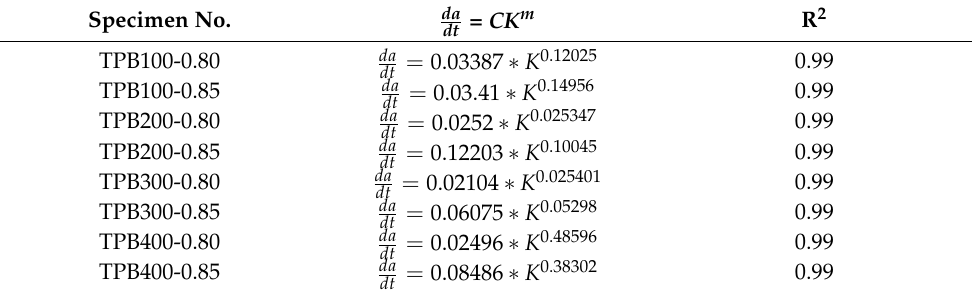
Table 4. Fitting result.